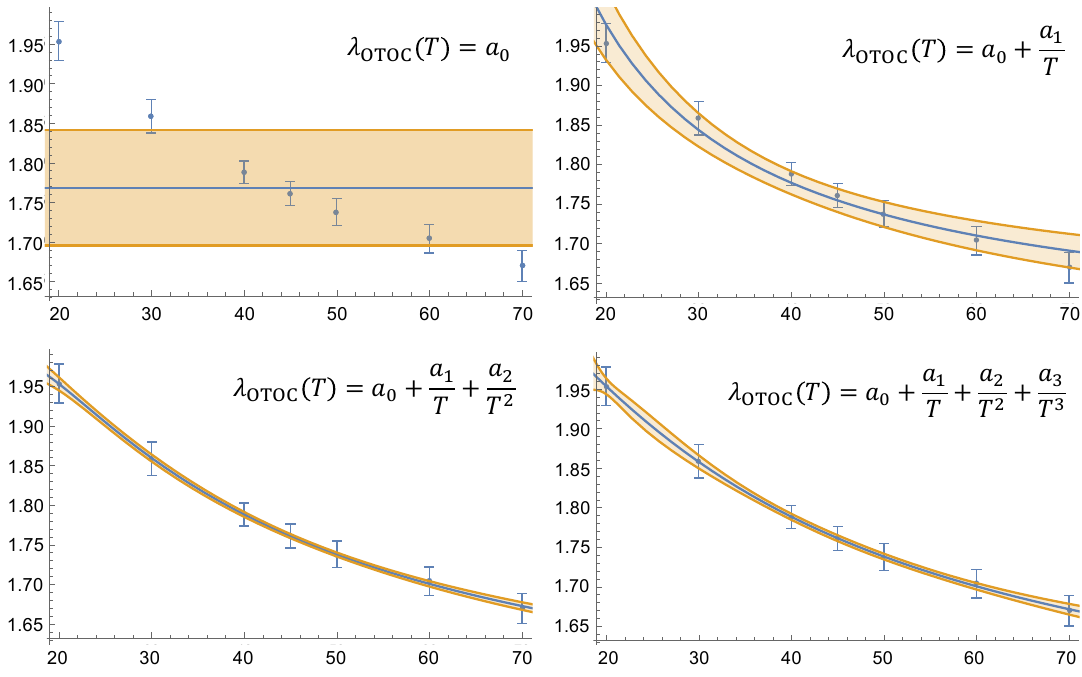
Figure 12 . Blue curves (lines): the fitting function. Yellow region: 95% confidence interval for the